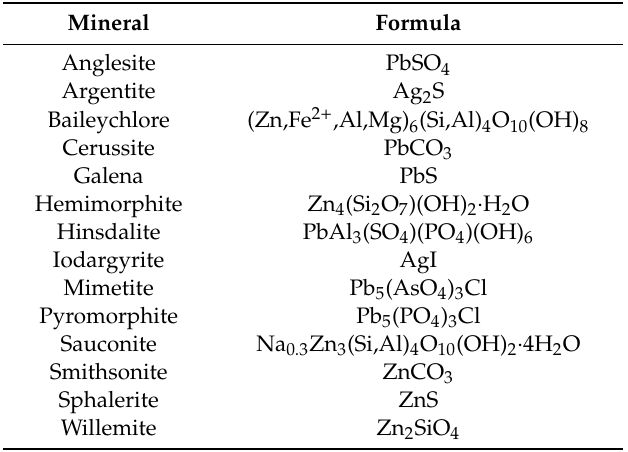
Table 2. Summary of the ore minerals detected in the Kihabe samples, with their International Mineralogical Association (IMA)-accepted chemical